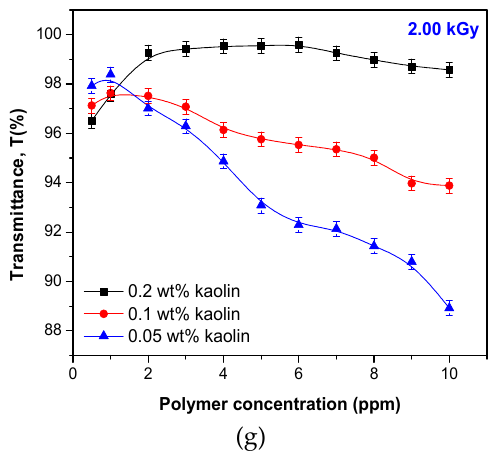
Figure 10. The influence of the kaolin concentration on the samples transmittance: AMD/ALg II obtained at 0.5 kGy ( a ), 0.75 kGy ( b ), 1 kGy ( c ), 1.25 kGy ( d ), 1.5 kGy ( e ), 1.75 kGy ( f ), and 2 kGy ( g ).